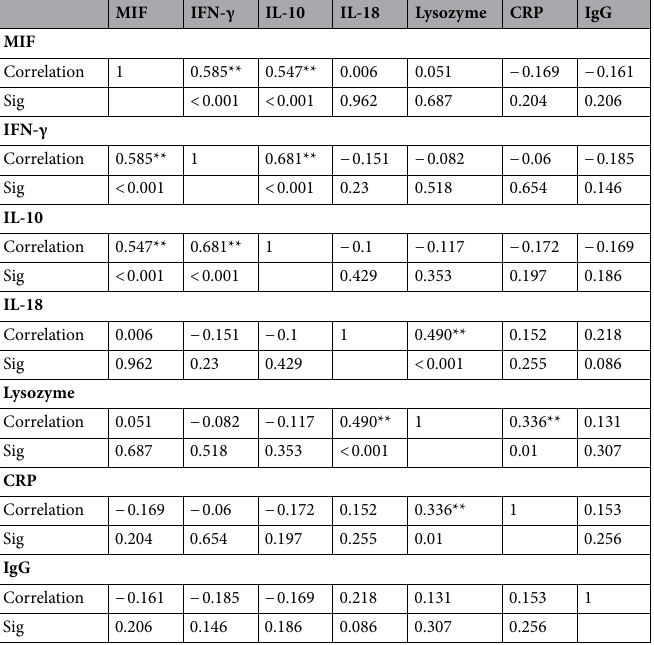
Table 3. Serum cytokines and biomarkers correlations. *Correlation is significant at the 0.05 level (2-tailed). **Correlation is significant at the 0.01 level (2-tailed).